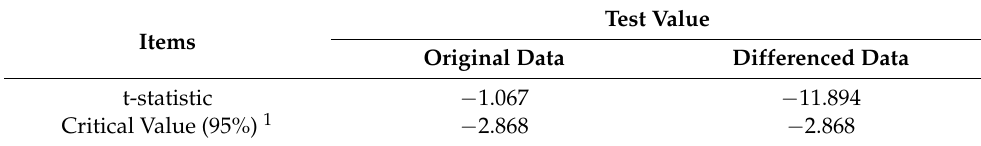
Table 1. Results of the Dickey–Fuller test.